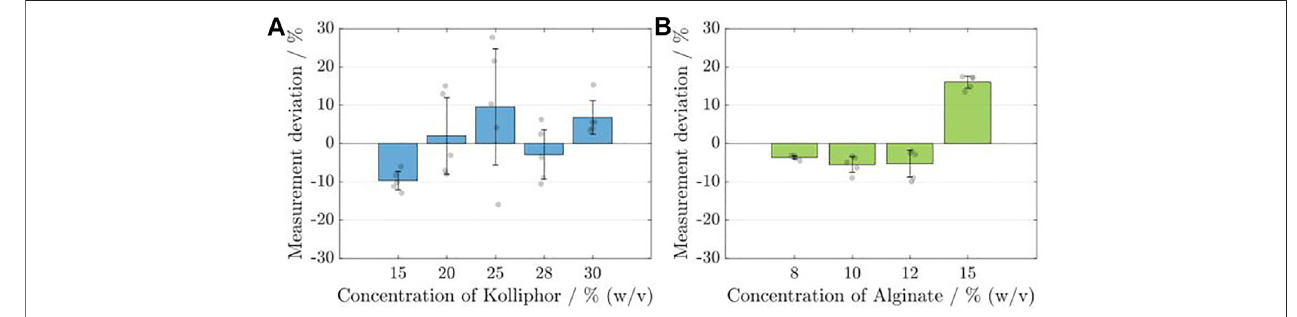
FIGURE4| Analysisofthecalibrationandmeasurementaccuracyofthe fl owsensorfortherespectiveKolliphor (A) andalginate (B) concentrations.Eachtime, fi ve identicalcylinders ( n sample =5)wereprinted,and thecalculatedvolumes basedonthesensordatawerecompared withthedatafromthegravimetricdetermination. The deviation of the sensor measurement is given in